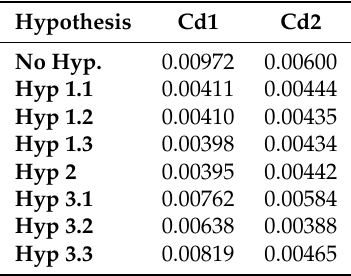
Table 8. Goodness of fit from Equation (5) of each hypothesis applied to the datasets of groups Cd1 and Cd2 at